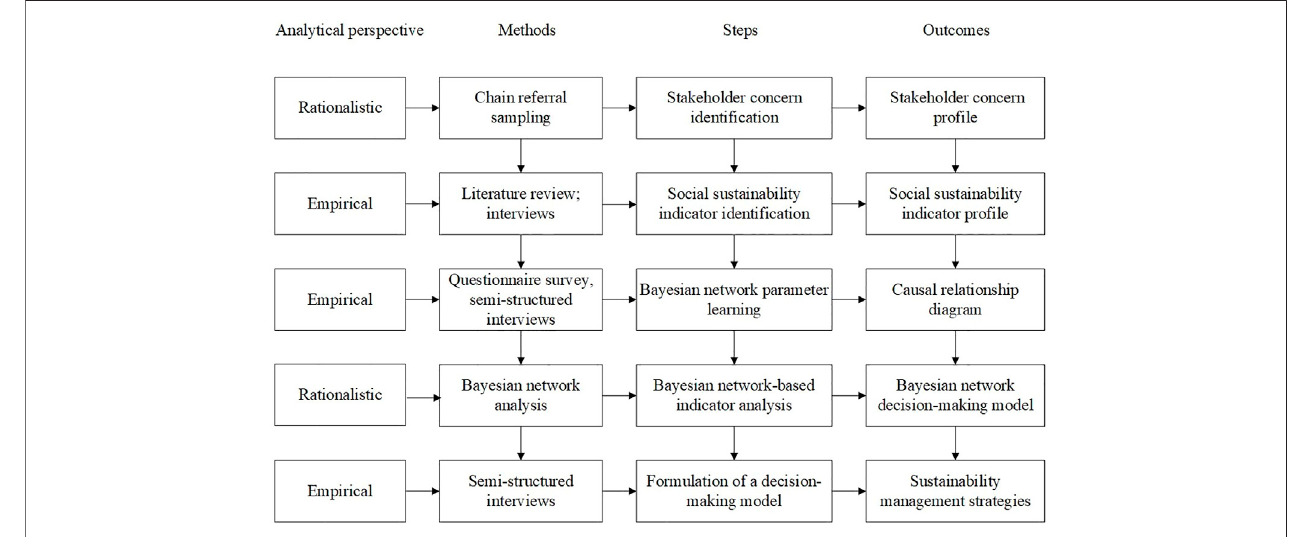
FIGURE 2 | SCSM implementing framework using